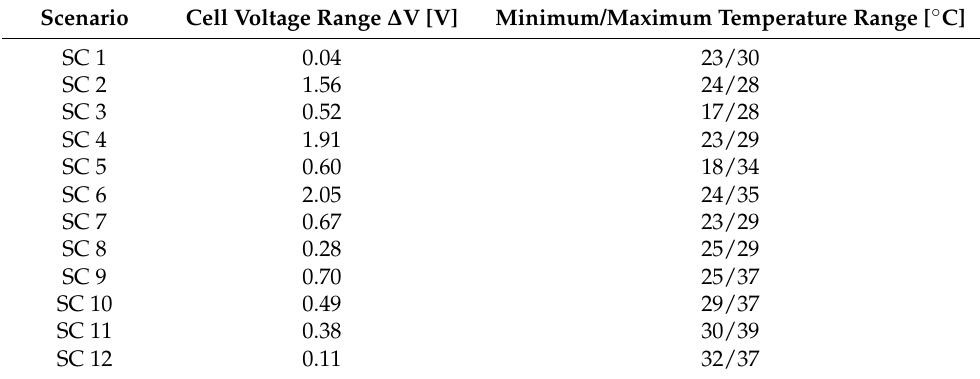
Table 4. Analysis of the obtained results according to the